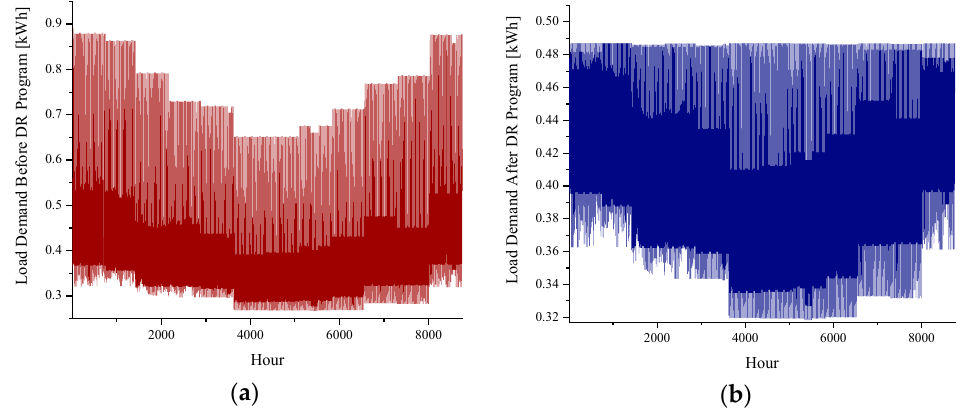
Figure 9. Load demand ( a ) before implementing the RTP-based DR program; ( b ) after implement- ing the RTP-based DR program.